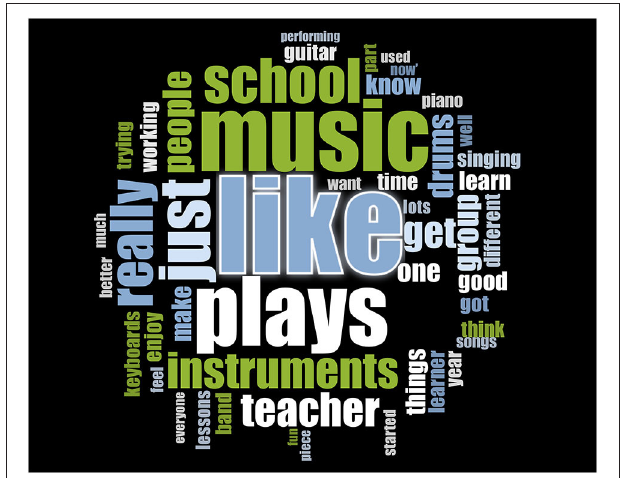
FIGURE 2 | Fifty more frequent words.